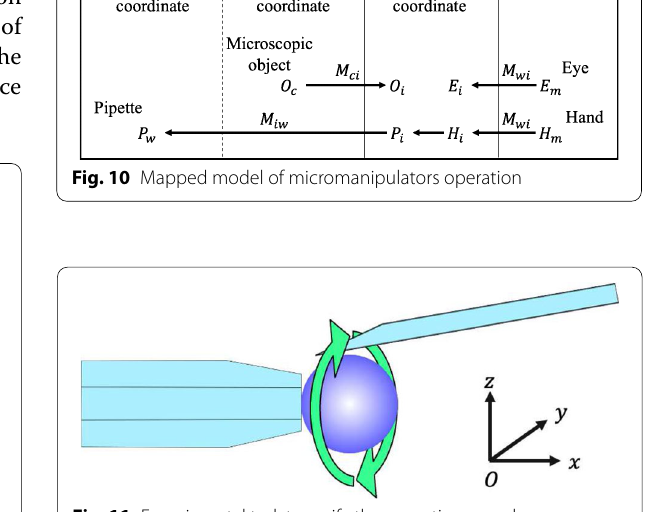
Fig. 8 Coordinate images